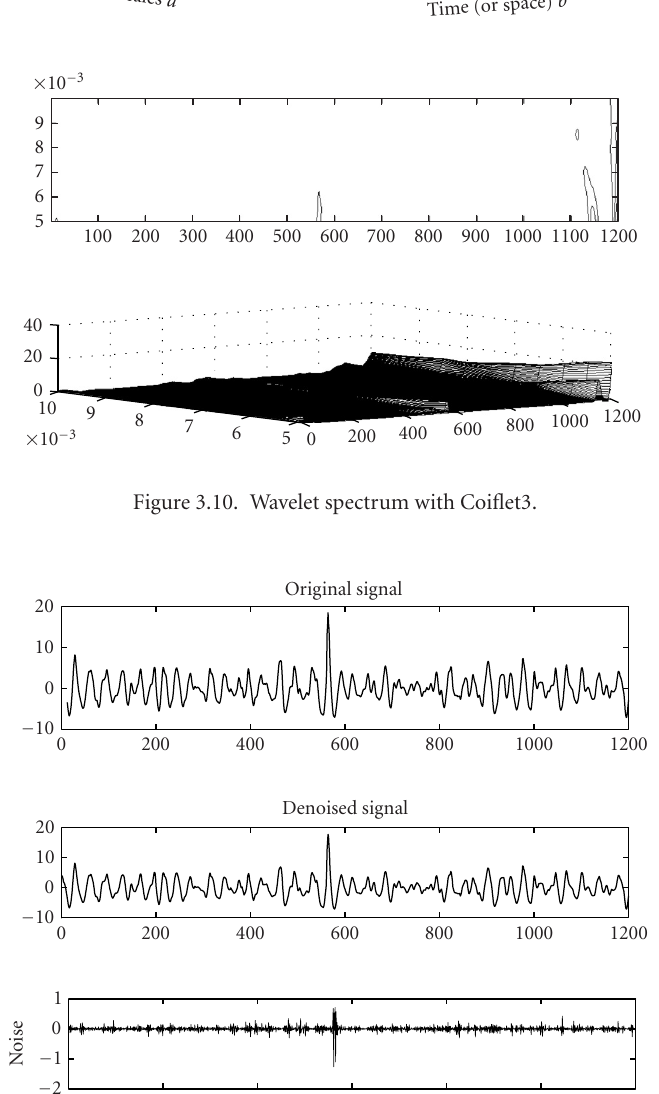
Figure 3.11. Denoising thr. db3 with global thresholding. (Zero Coe ffi cients: 50%, 2-norm recon- struction: 90 .